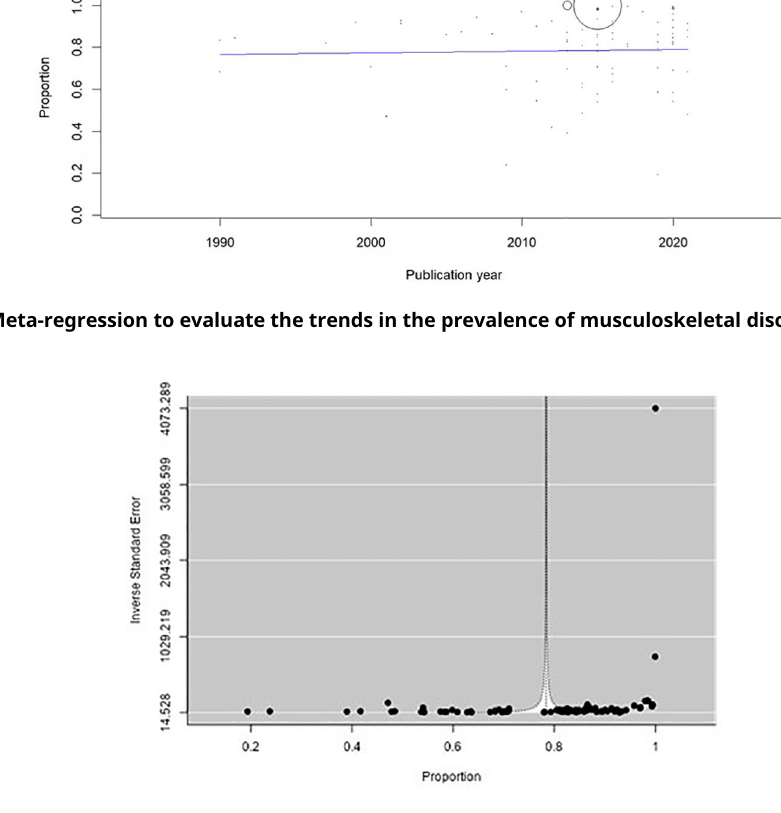
Figure 5. Funnel plot to evaluate the publication